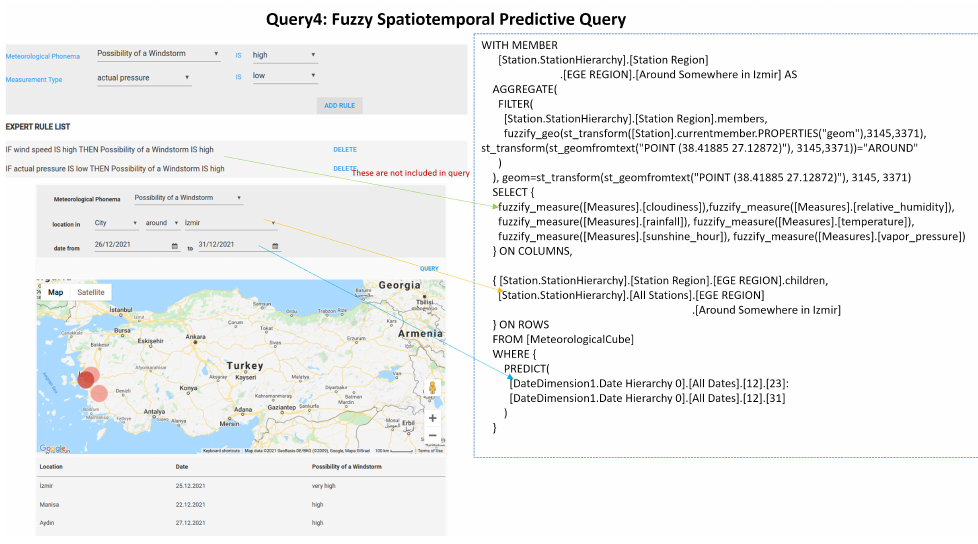
Figure 17. Fuzzy spatiotemporal predictive query.